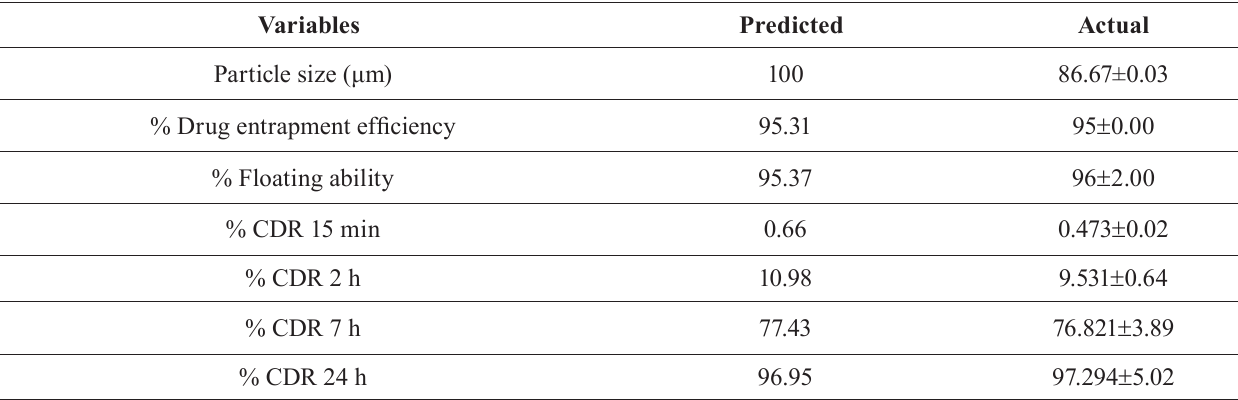
TABLE VI - Actual and predicted values of optimized formulation